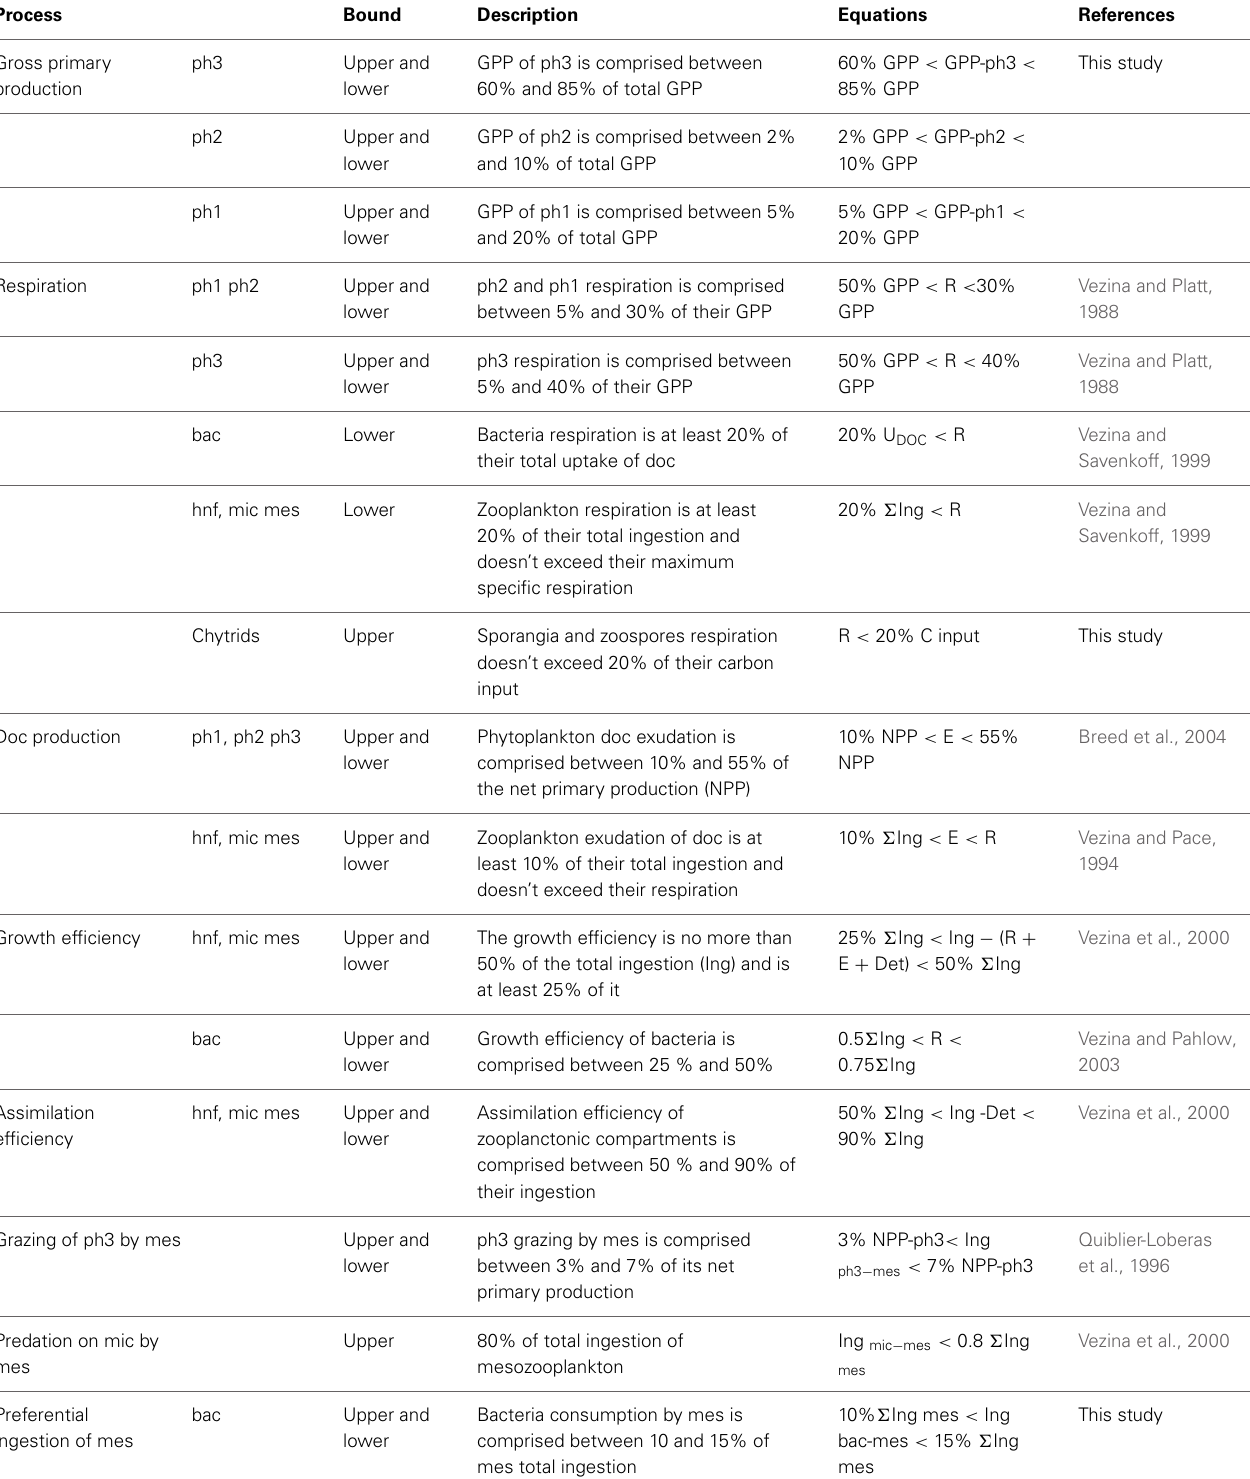
Table 2 | Constraints used on different planktonic food web